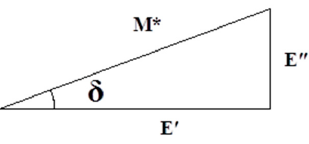
Figure 3. Relationship between the loss angle and modulus.